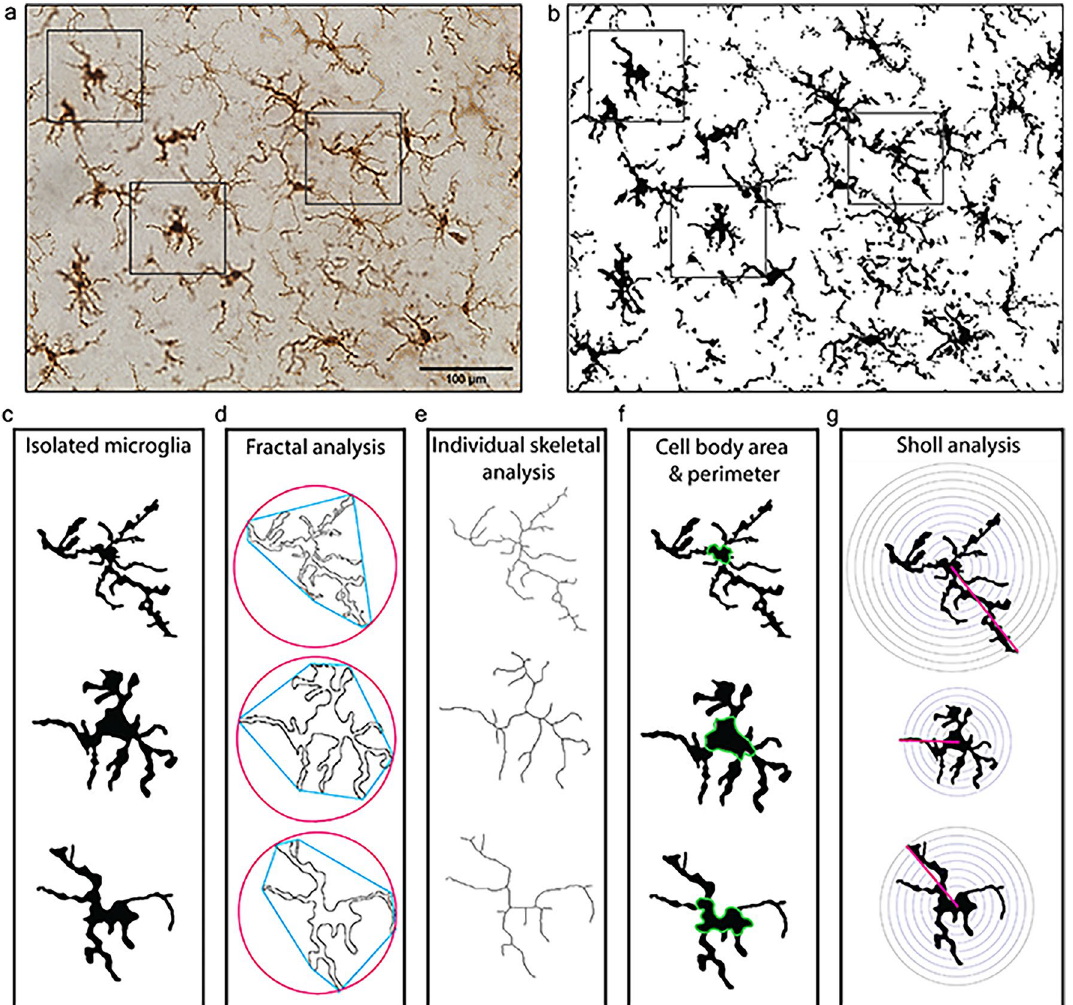
Figure 2. Single cell methods to assess microglial morphology in ImageJ. ( a ) Photomicrograph of Iba1- stained microglia. ( b ) Photomicrograph of Iba1-stained microglia in binary. Boxes indicate microglia that were randomly selected for isolation. ( c ) Binary isolated microglia. ( d ) For fractal analysis, isolated microglia were converted to outlines and analyzed using the FracLac plugin. ( e ) For individual skeletal analysis, microglia were skeletonized and analyzed using the skeletal analysis plugin. ( f ) Cell body area and perimeter were measured using the multipoint area selection tool. ( g ) Sholl analysis was performed to measure cell branching using concentric circles. Scale bar = 100 µm, applied in ( a , b